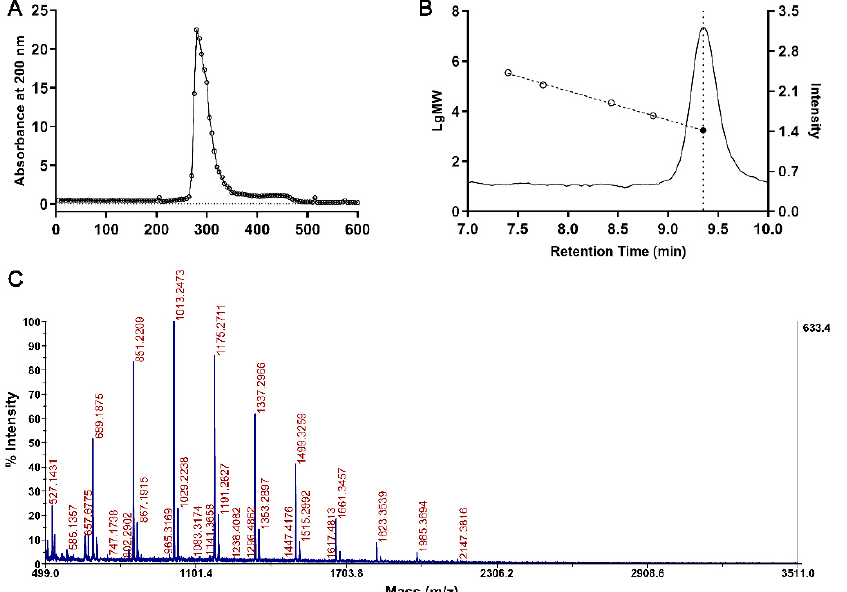
Figure 1. Purification and molecular weight characterization of As sP. ( A ) The extracted As sP was concentrated and the impurities were removed with a S-400 HR gel filtration chromatography column. Each 5 mL of elution was collected, and the content of total carbohydrates in each fraction was monitored by its absorbance at 200 nm. ( B ) Gel permeation chromatogram of the polysaccharide standards (not shown) and purified As sP (right y axis). The retention time and log value of molecular standards (empty circles) regressed into a linear relationship with the R 2 value of 0.99 (left axis). The retention time of As sP (dotted line vertical to the x -axis) corresponds to a molecule weight of 1722 Da (filled dot, intercept with the standard curve). ( C ) MALDI-TOF/TOF mass spectrum of purified As